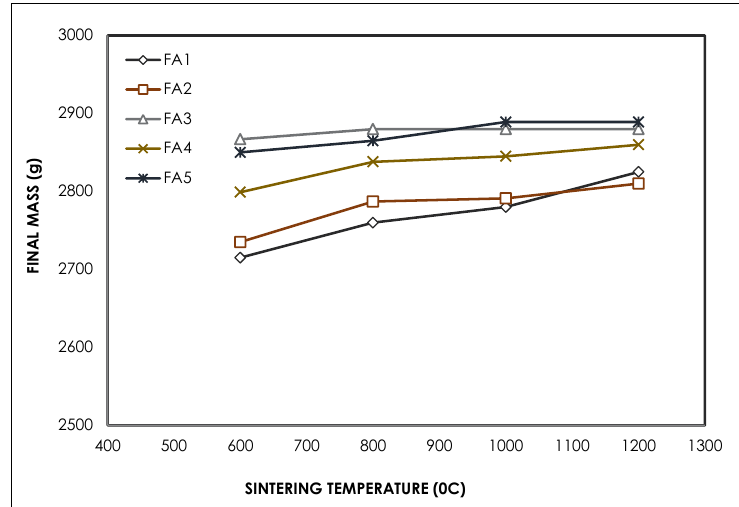
Figure 5: Final mass studied brick specimens after 12cycles